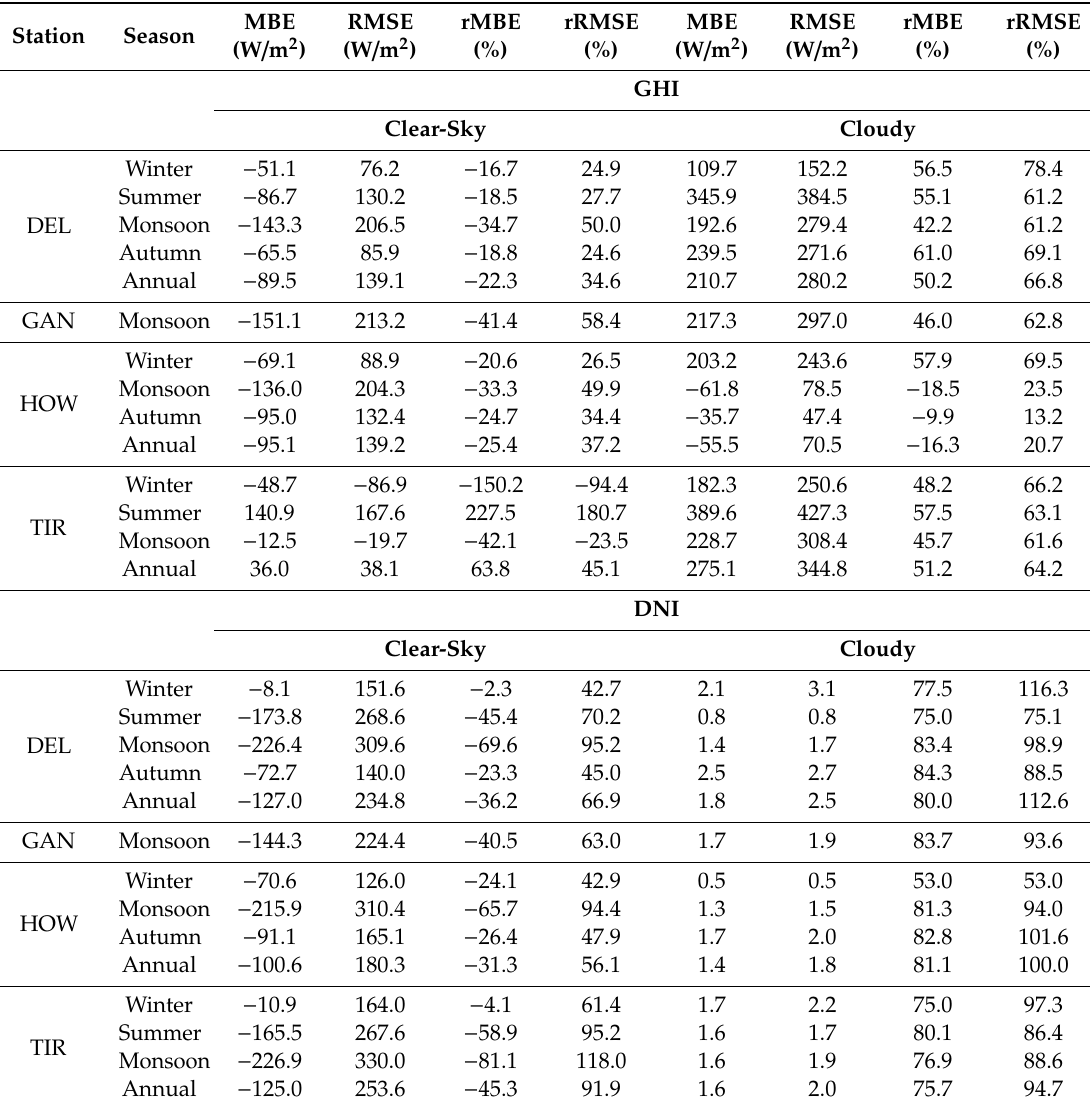
Table 3. INSIOS model statistical scores of GHI and DNI estimation for clear-sky and cloudy conditions. MBE: mean bias